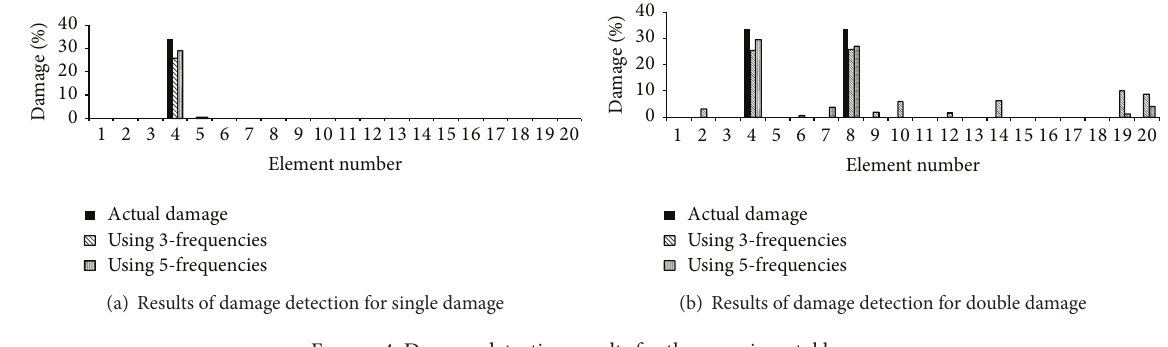
Figure 4: Damage detection results for the experimental beam.